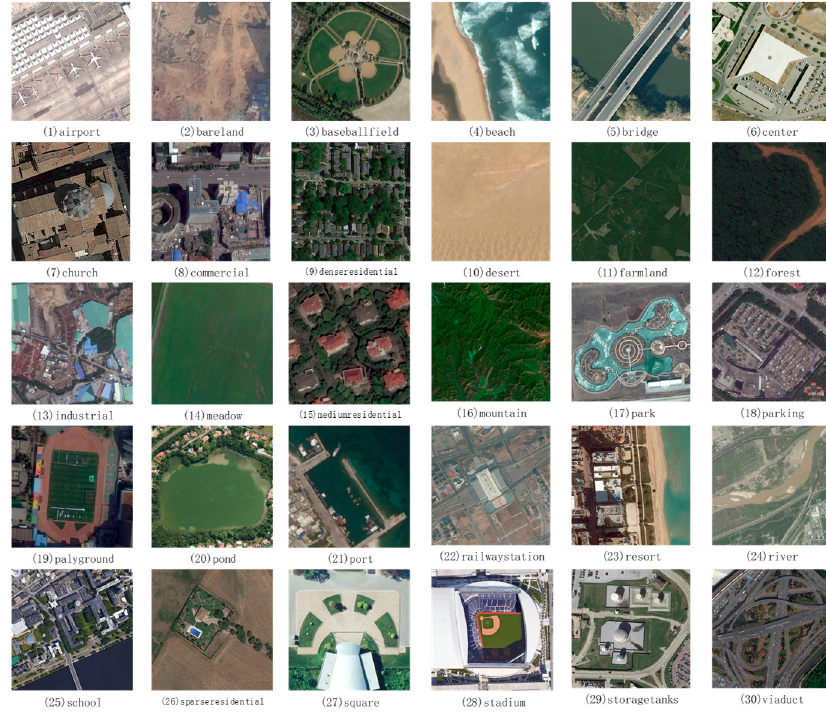
Figure 5. Sample images of AID dataset.